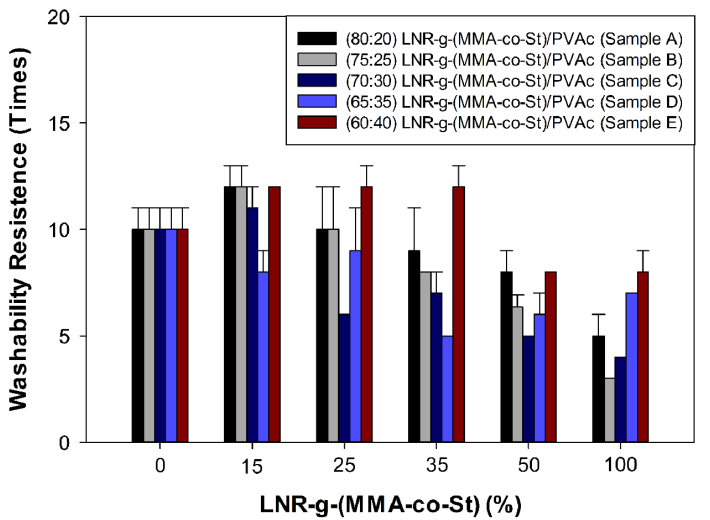
Figure 4. Washability resistance of emulsion paints with LNR-g-(MMA-co-St)/PVAc binder